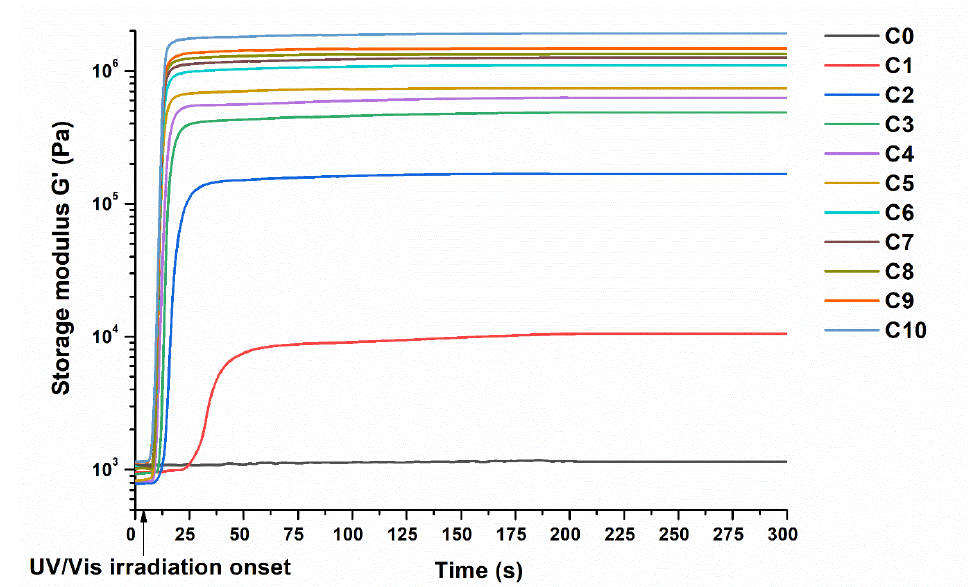
Figure 3. Dependency of the storage modulus G ′ of resins C0 – C10 on the irradiation